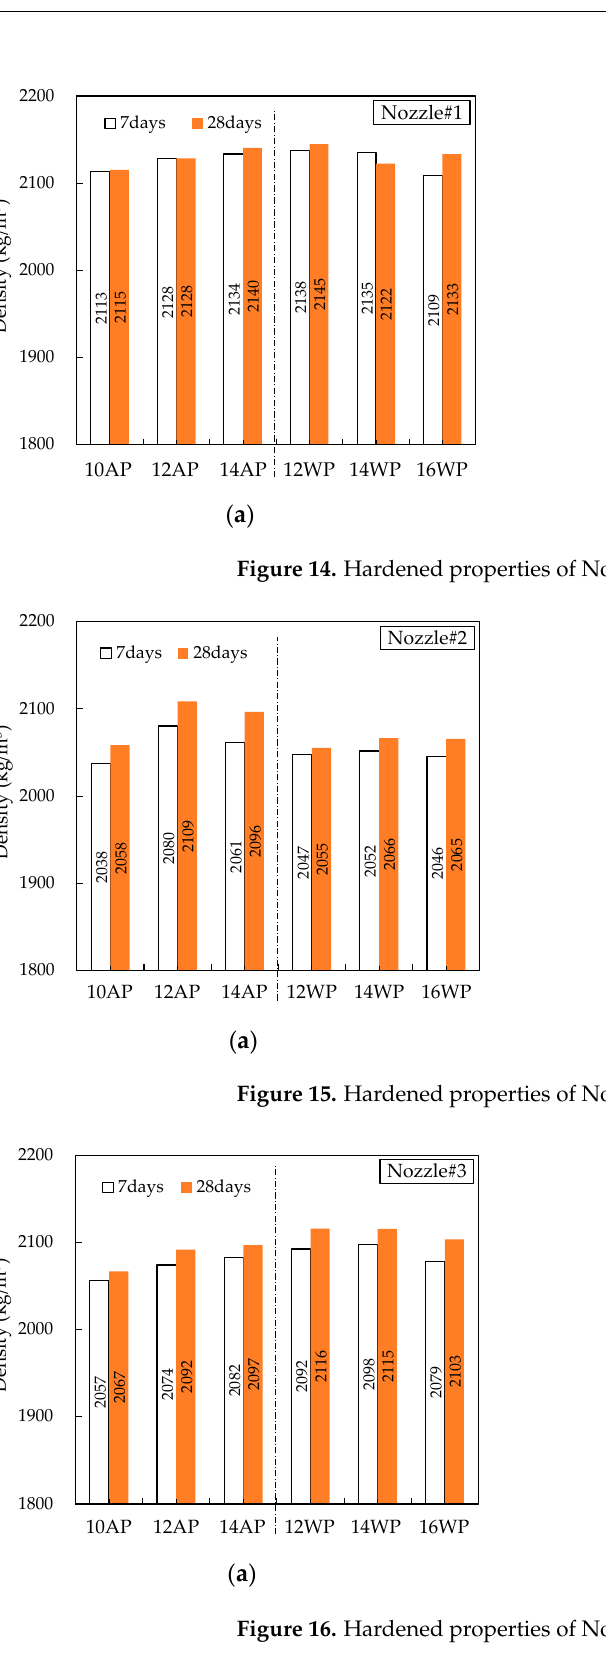
( b ) Figure 17. Hardened properties of Nozzle#4 specimens: ( a ) density; ( b ) compressive strength. ( a ) ( b ) Figure 18. Hardened properties of Nozzle#5 specimens: ( a ) density; ( b ) compressive strength. In almost all specimens, the density increased with increasing age. The additional production of hydrates by the hydration reaction apparently contributed to the density increase. The density of the WP specimen was slightly lower than that of the AP specimen because the cohesion between the cement paste particles was reduced and loosened owing